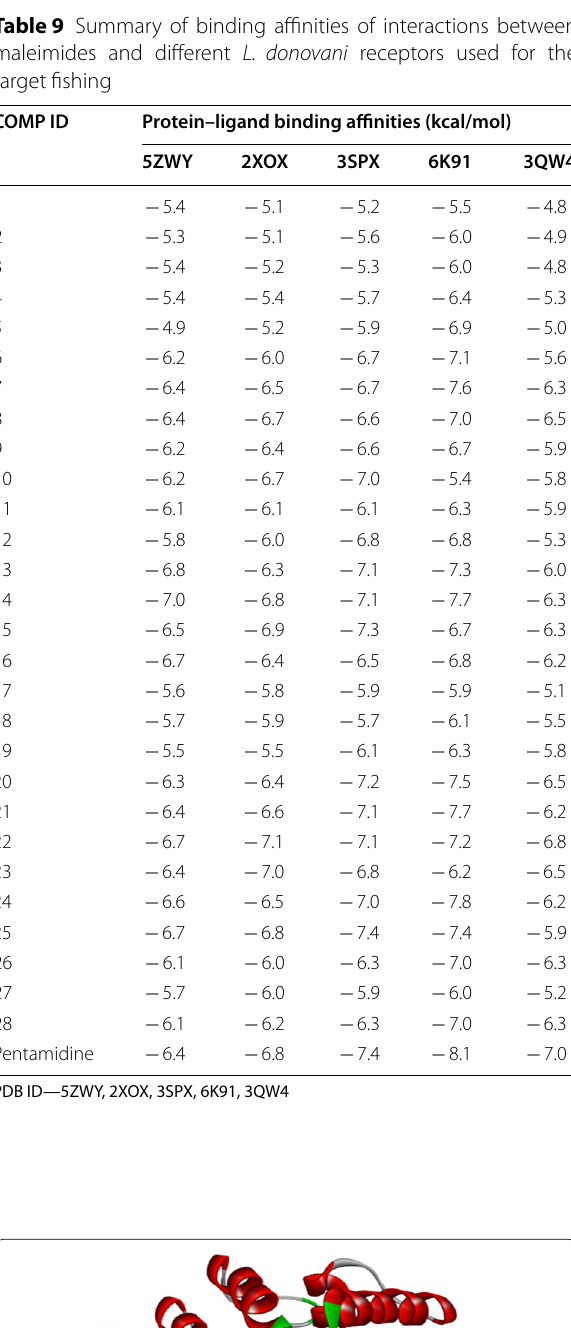
Table 8 Y -randomization test parameters